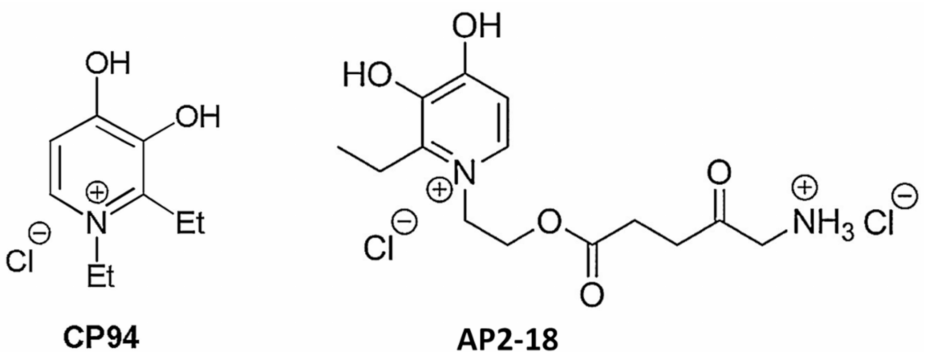
Figure 5. Molecular structures of the hydroxypyridinone iron chelator, CP94, 1,2-diethyl-3- hydroxypyridin-4-one, together with AP2–18; the aminolevulinic acid (ALA) prodrug